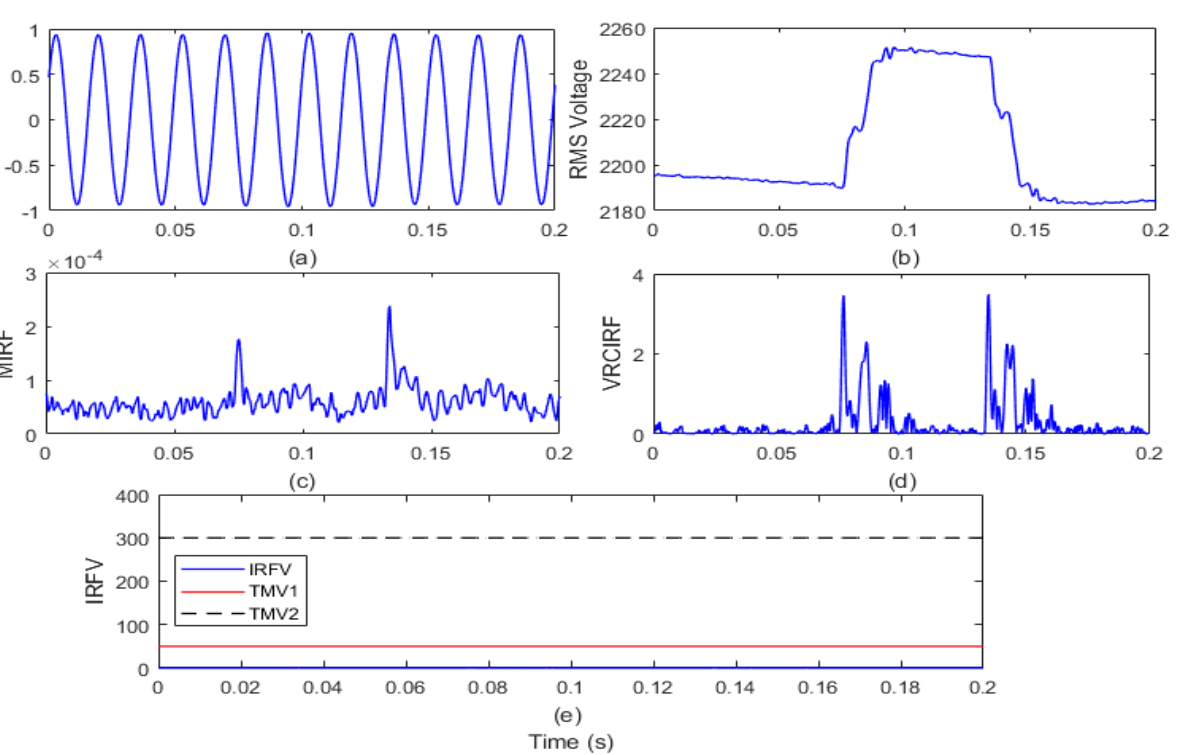
Figure 17. Load switching ( a ) voltage signal ( b ) root means square value of voltage ( c ) median-based IRF ( d ) rate of change in voltage-based IRF ( e ) islanding recognition factor based on voltage.